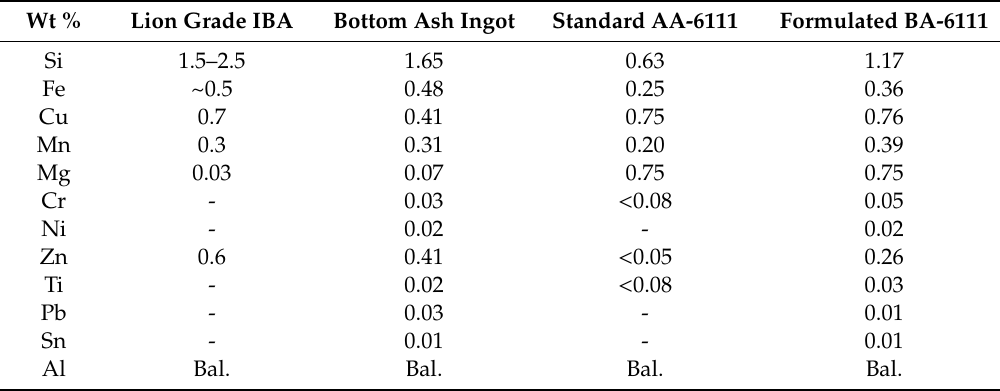
Figure 1. Incinerator bottom ash aggregates, bottom ash ingot and the dross left after crucible casting. Table 1. Chemical composition of lion grade IBA, bottom ash ingot, standard AA-6111 and formulated BA-6111